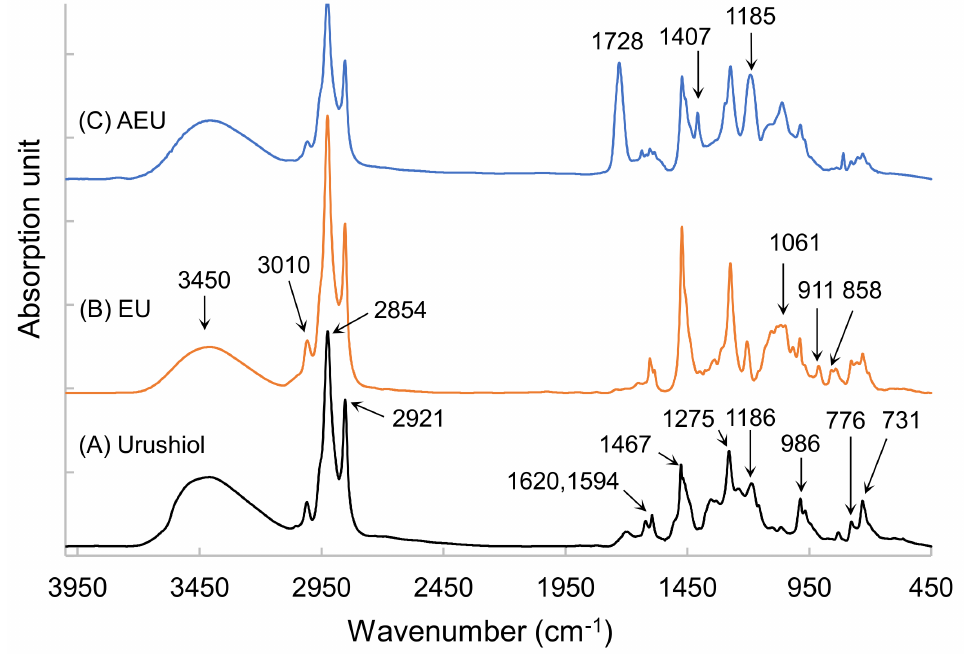
Figure 3. FTIR spectra of ( A ) urushiol, ( B ) EU, and ( C ) AEU. After the reaction of the epichlorohydrin and the urushiol, the peaks appeared at 858 cm − 1 and 911 cm − 1 , which related to the epoxide group in the EU spectrum (as shown in Figure 3B). The peak at 1061 cm − 1 represented the C–O linkages. Besides, the